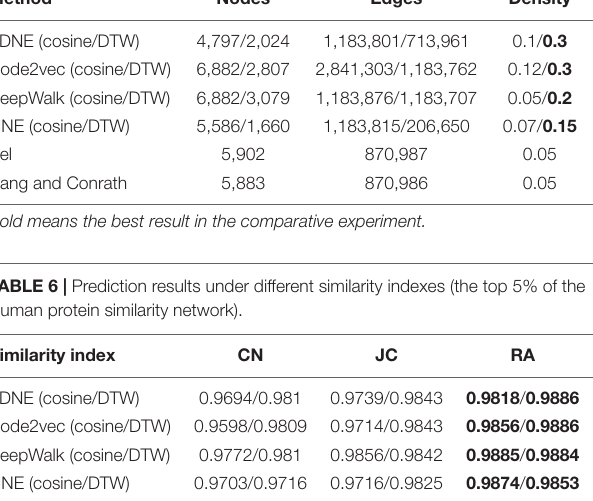
TABLE 5 | Comparison of Human protein similarity network density between different methods. Method Nodes